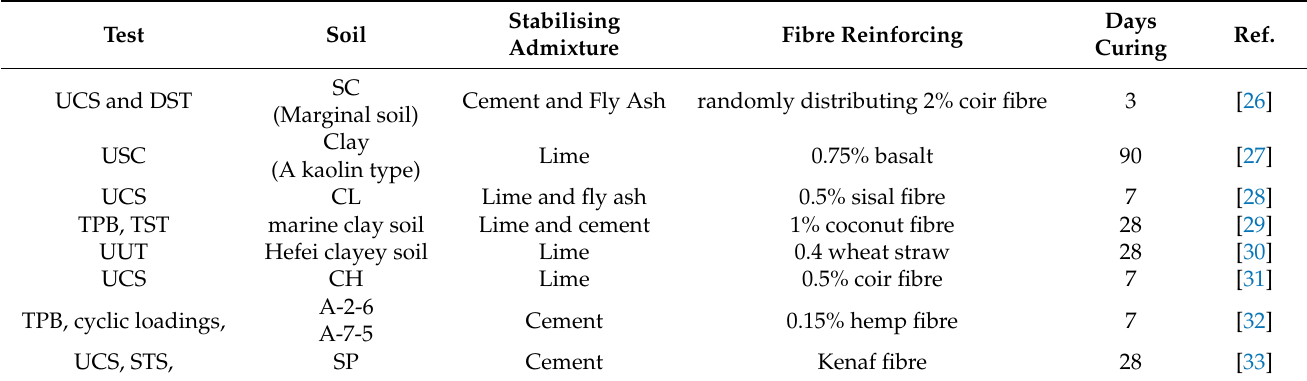
Table 1. Natural fibre and additives investigated in some previous